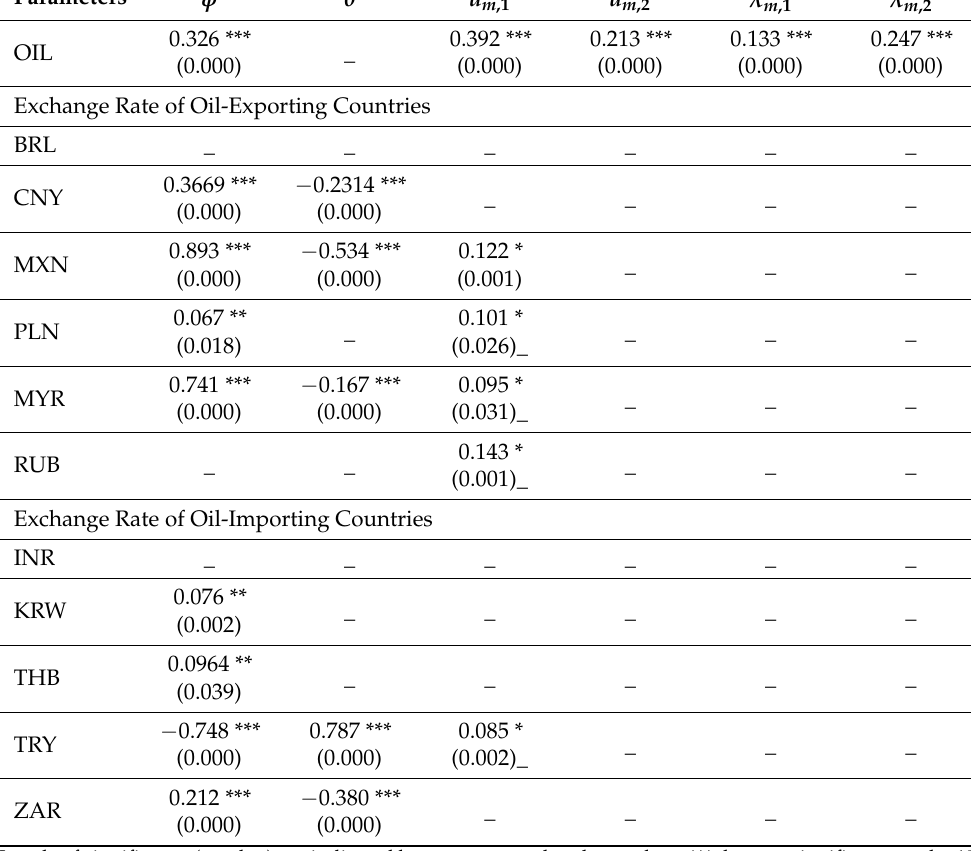
Table 3. Mean equation estimation.